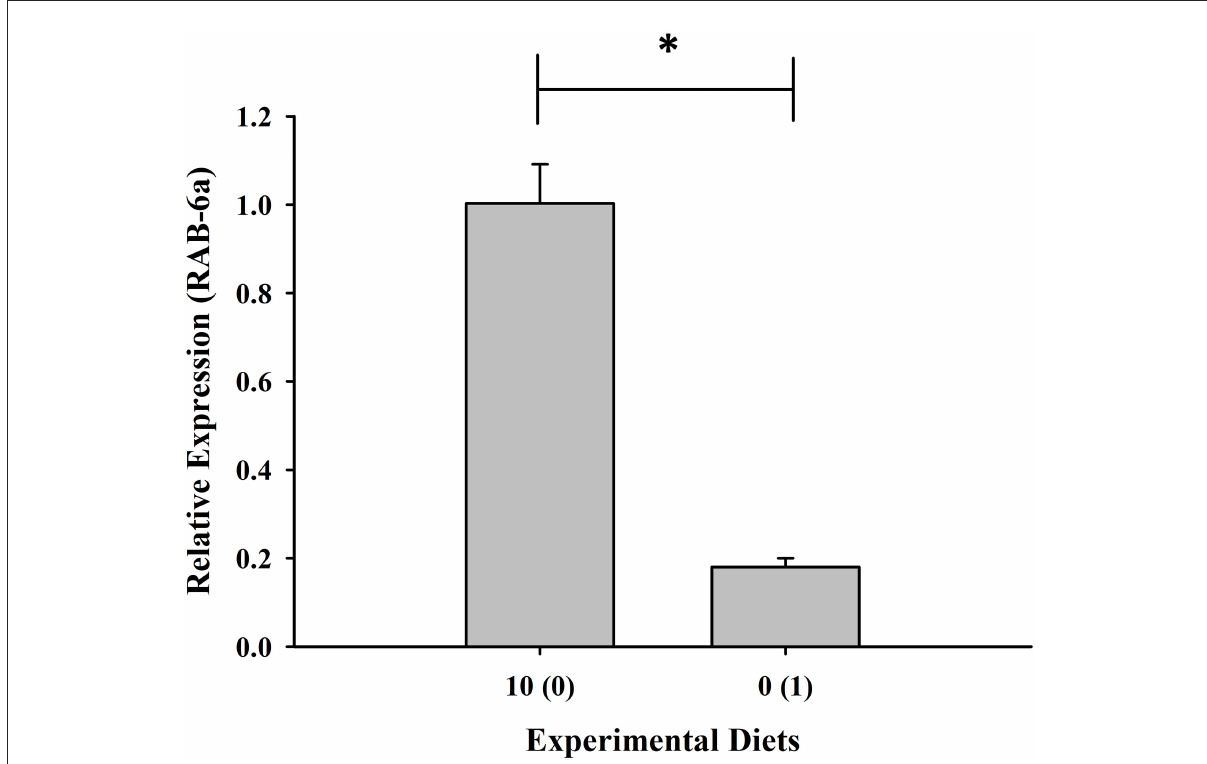
FIGURE5 Relative expression of RAB-6a, a gut pro-inflammatory gene, of shrimp fed with plant-based diets supplemented with squid by-product hydrolysate. The asterisk indicates a significant difference between